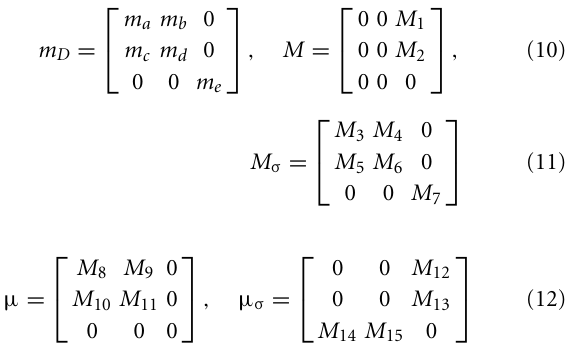
according to different neutrino e : ν μ